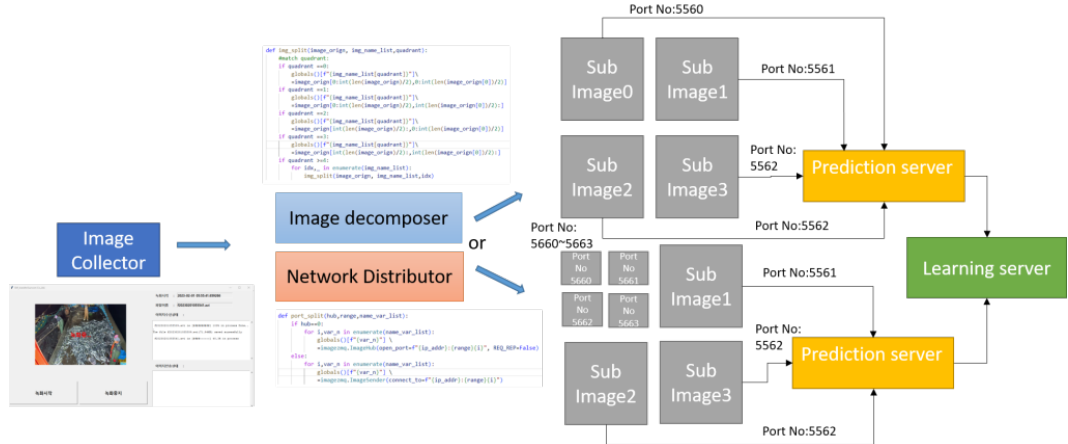
Figure 5. A conceptual diagram of the image segmentation estimation technique.